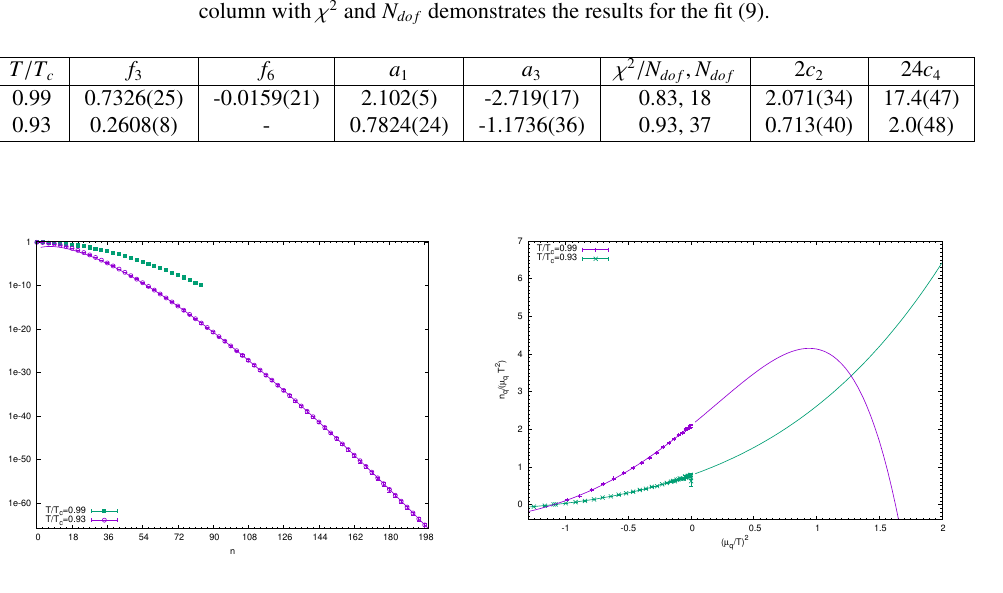
Figure 4. Analytical continuation for the number den- sity vs. µ 2 for all temperature values. The curves show q respective fits, details of the fits are declared in Table 1.